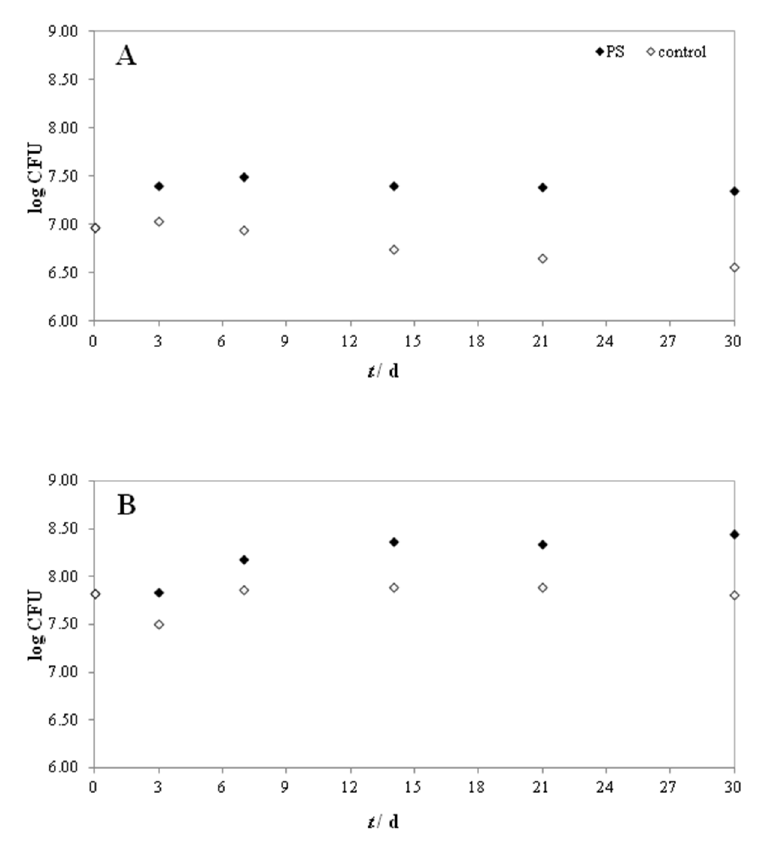
Figure 2. Changes of log CFU of ( A ) Bacillus cereus in experiment M1-24 and ( B ) Pseudomonas alcaligenes in experiment M2-23 during 30 days of MP-PS biodegradation.